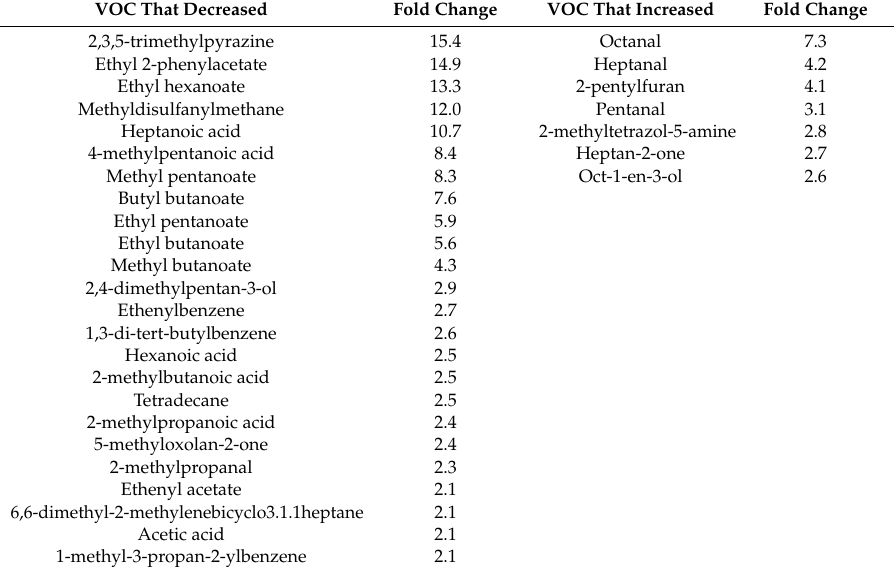
Table 3. Summary of fold change data in Group